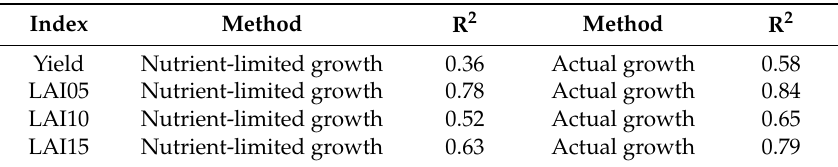
Table 9. The accuracy of crop growth simulations.